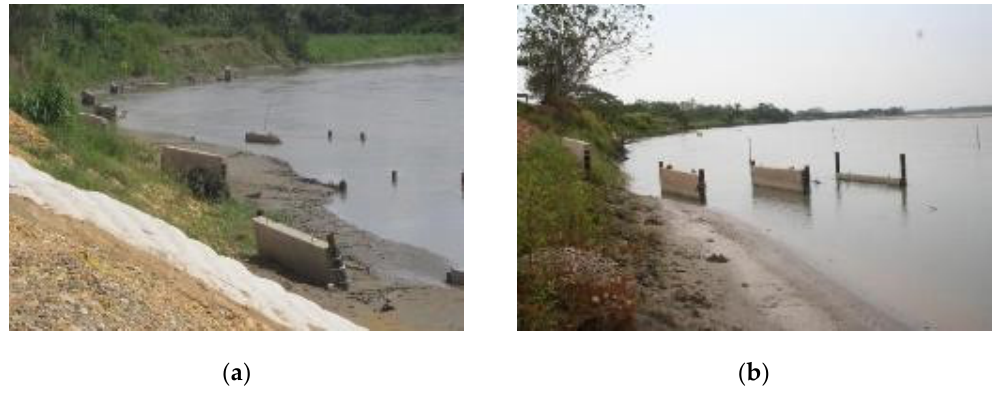
Figure 32. Ariari River, PR68: sedimentation in process around the vanes. ( a ) In the upstream sector; ( b ) before the straight section (Source: Hidroconsulta).